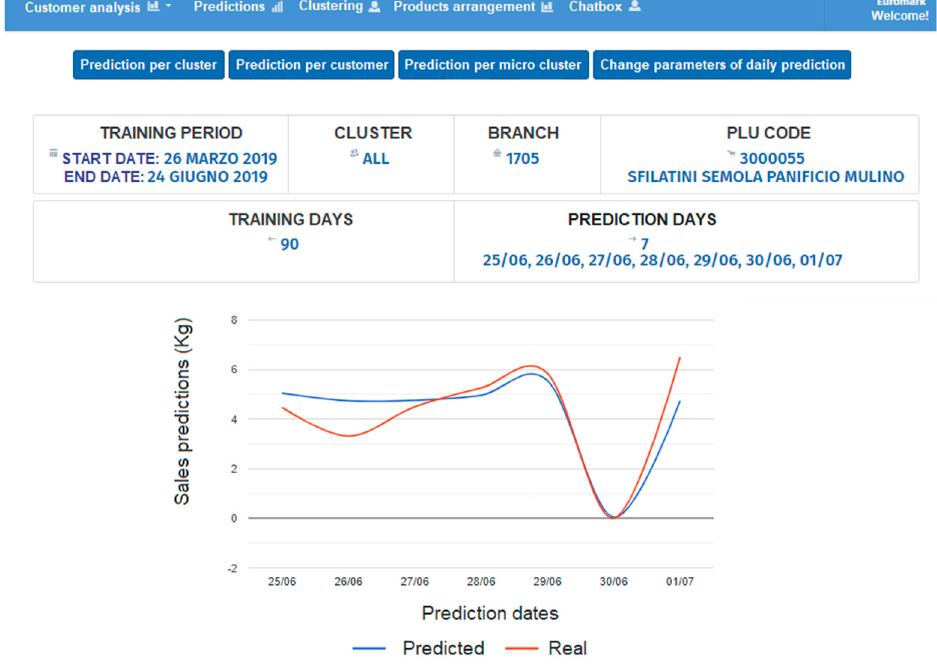
Figure 8. Project platform dashboard implemented for setting the prediction parameters and for viewing the results.